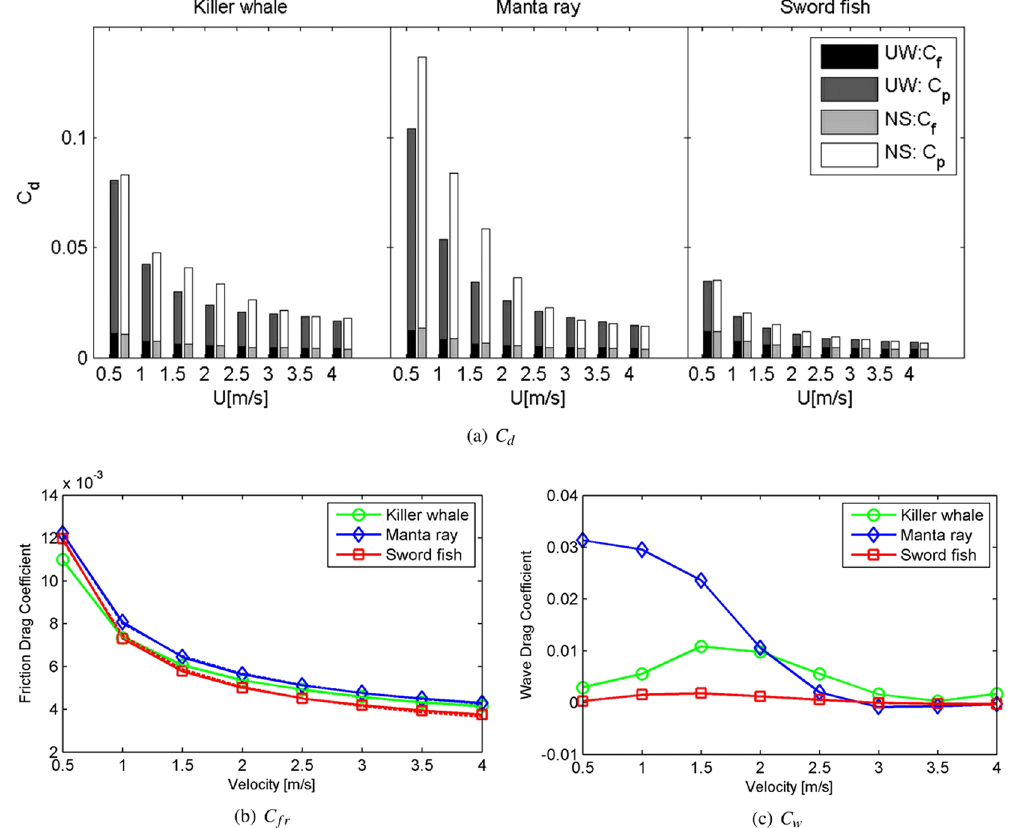
Figure 3. Drag coefficients at various swimming speeds: ( a ) left column: C D for Case UW; right column: C D for Case NS; top row: C p ; bottom row: C fr ; ( b ) C fr for Case UW. Solid line: CFD simulation results; dashed line: fitting function in Eq. 3; ( c ) C w for Case